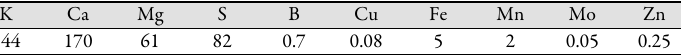
Table 1. Nutrient solution formulation used for broccoli production in outdoor hydroponic system Element N P K Ca Mg S Zn Concentration (mg L -1